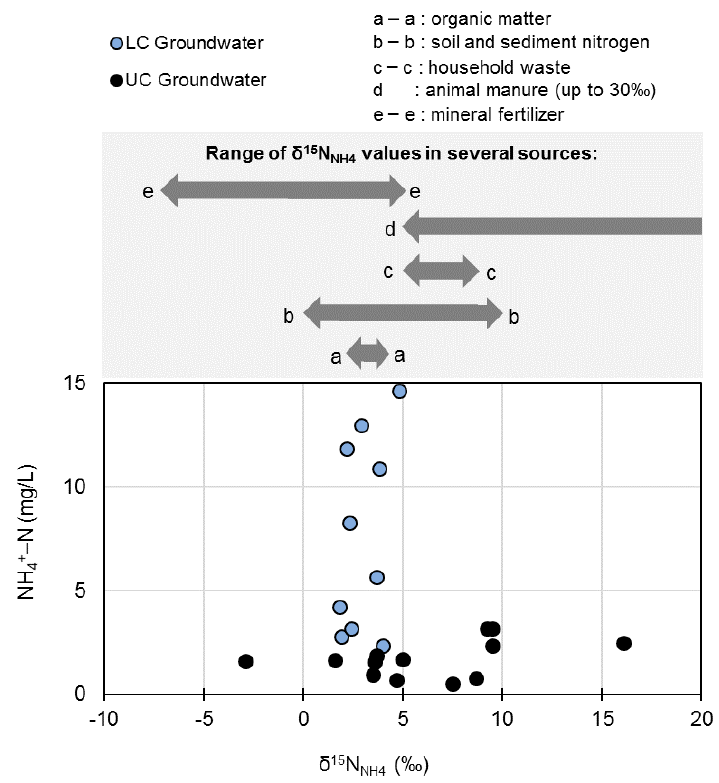
Figure 7. NH 4+ –N concentrations (mg/L) and δ 15 N NH4 values (‰) in the groundwater samples, and potential sources of NH 4+ –N based on δ 15 N NH4 values of several sources (ranges values of δ 15 N NH4 compositions for soil nitrogen, animal manure, and mineral fertilizer are adapted from Norrman et al. 2015 [6]; and for organic matter and household waste are adapted from Nikolenko et al. 2018 [19]).